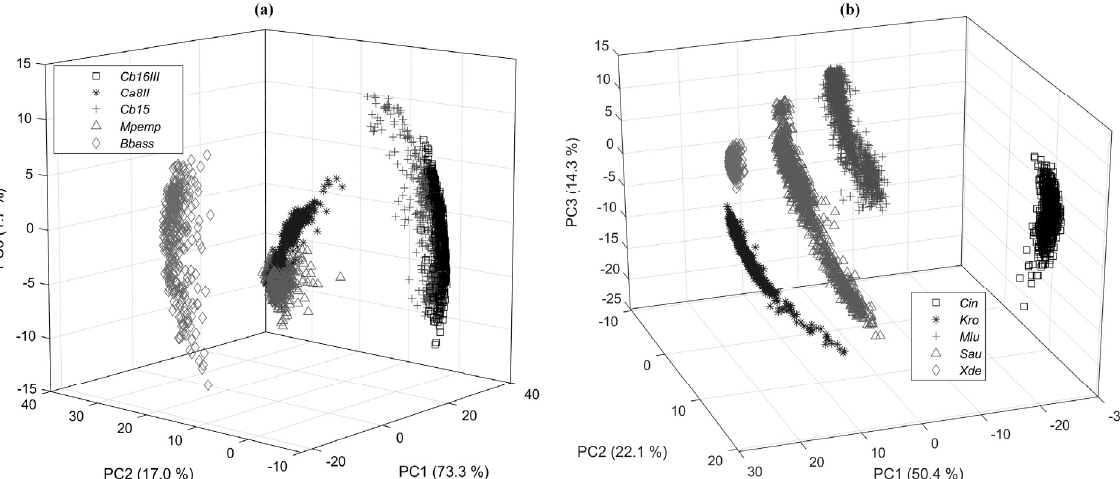
Figure 3. First three PCs of a PCA with the pretreated Raman spectra of the fungal spores ( a ) and carotenoid-containing microorganisms ( b ).